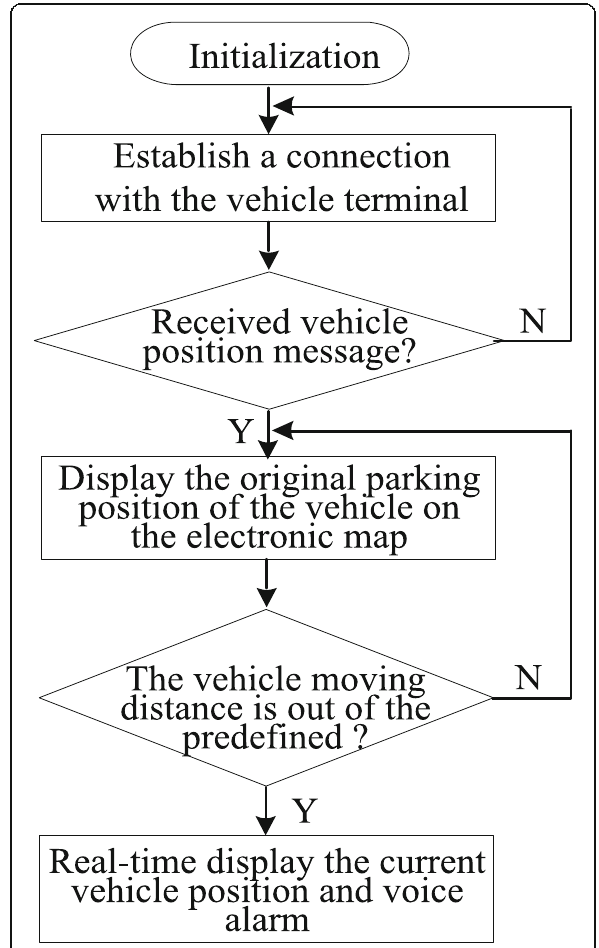
Fig. 8 Flow chart of user terminal vehicle monitoring